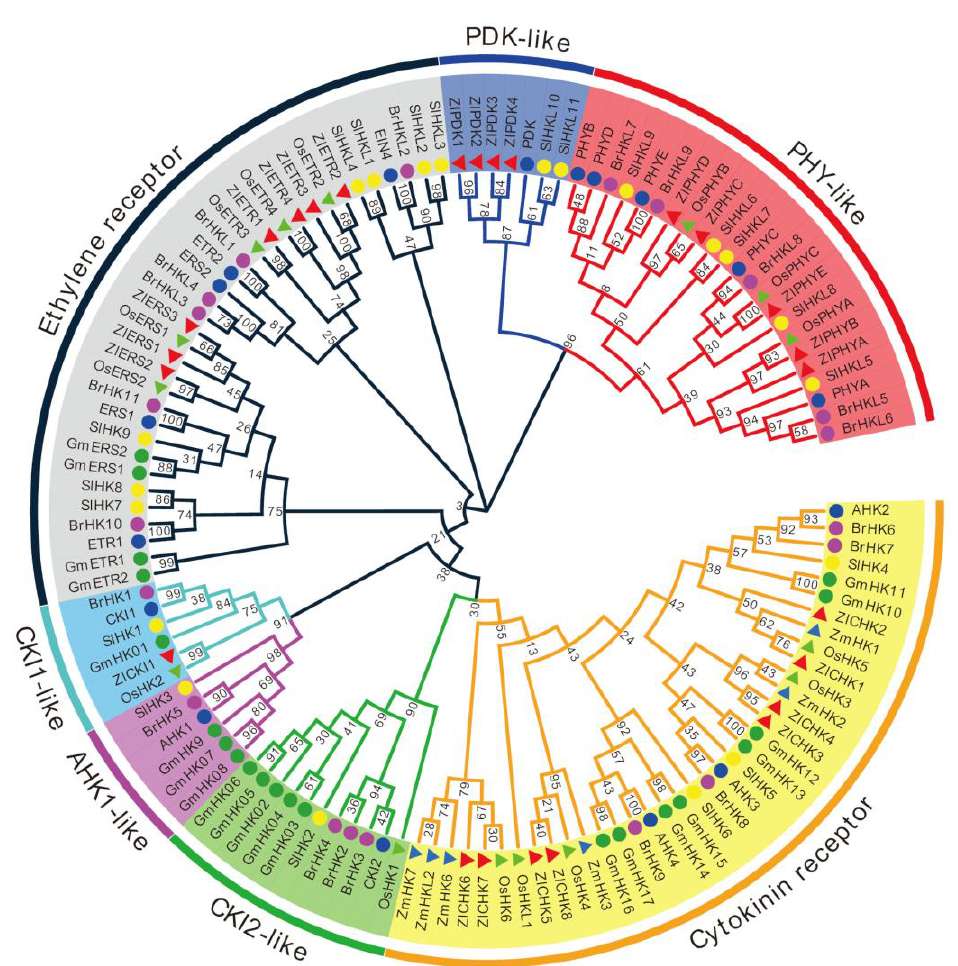
Figure 2. Phylogenetic relationship of HK(L) proteins in Arabidopsis , rice, maize, soybean, Chinese cabbage, tomato, and Z. latifolia. A maximum likelihood phylogenetic tree indicates the different subgroups of HK(L)s in different colors.